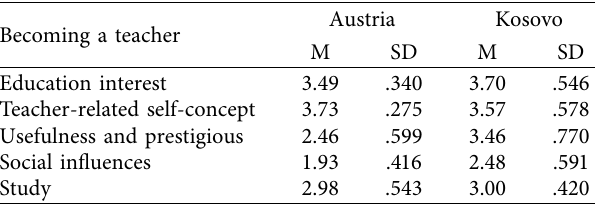
Table 3: Mean and standard deviation of five factors of becoming a teacher (first-year fall,